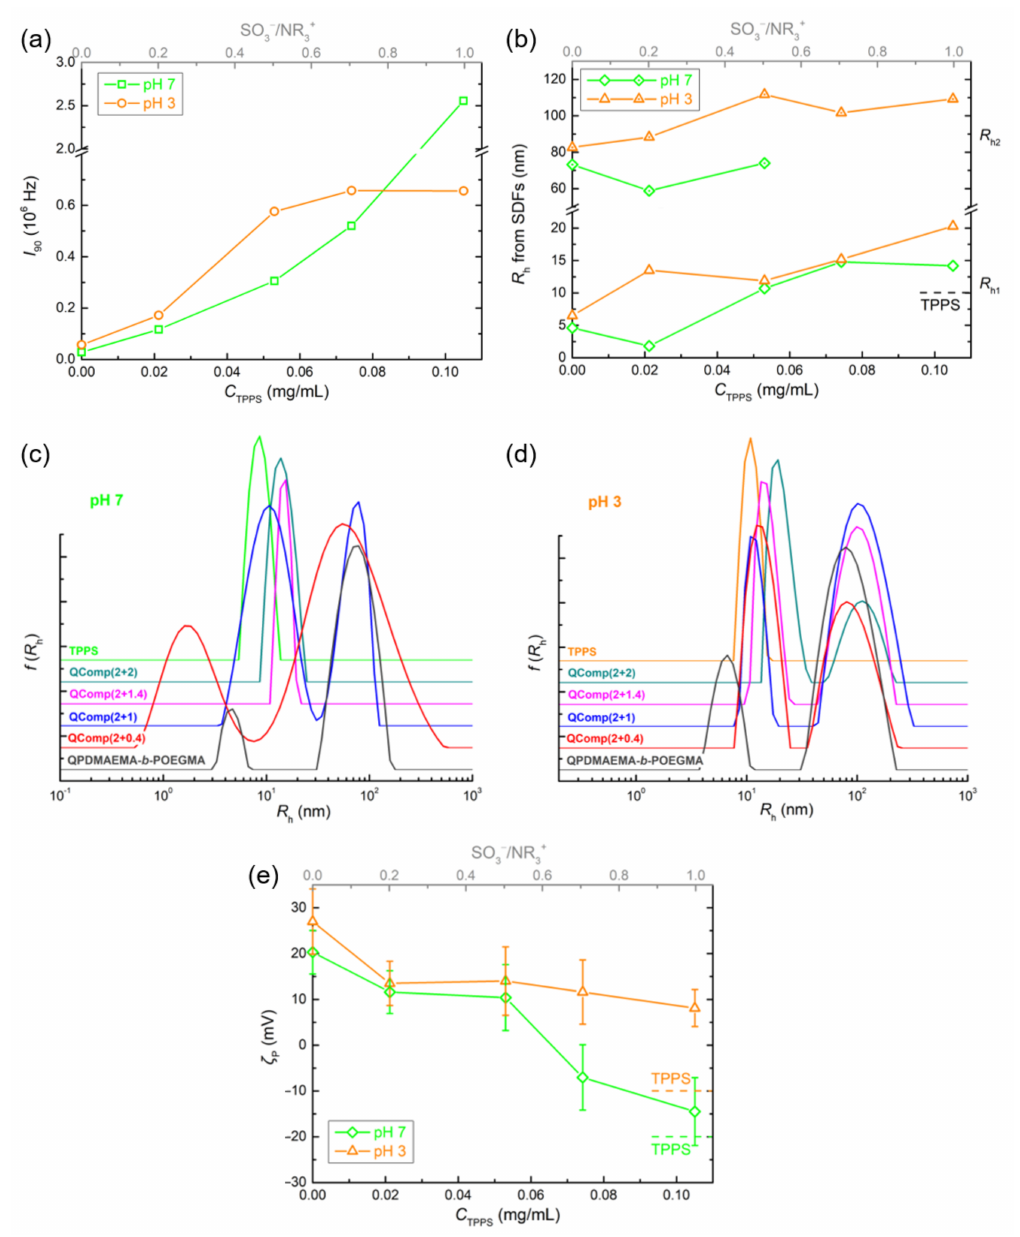
Figure 6. Collective DLS and ELS results in regard to ( a ) the scattering intensity at 90 ◦ , ( b ) the hydrodynamic radius derived from ( c , d ) the corresponding size distribution functions (SDFs) at 90 ◦ , and ( e ) zeta potential values for the QDHBC/TPPS complex solutions at pH 7 and 3, as a function of porphyrin concentration C TPPS or charged groups ratio SO 3 − /NR 3 + (R = CH 3